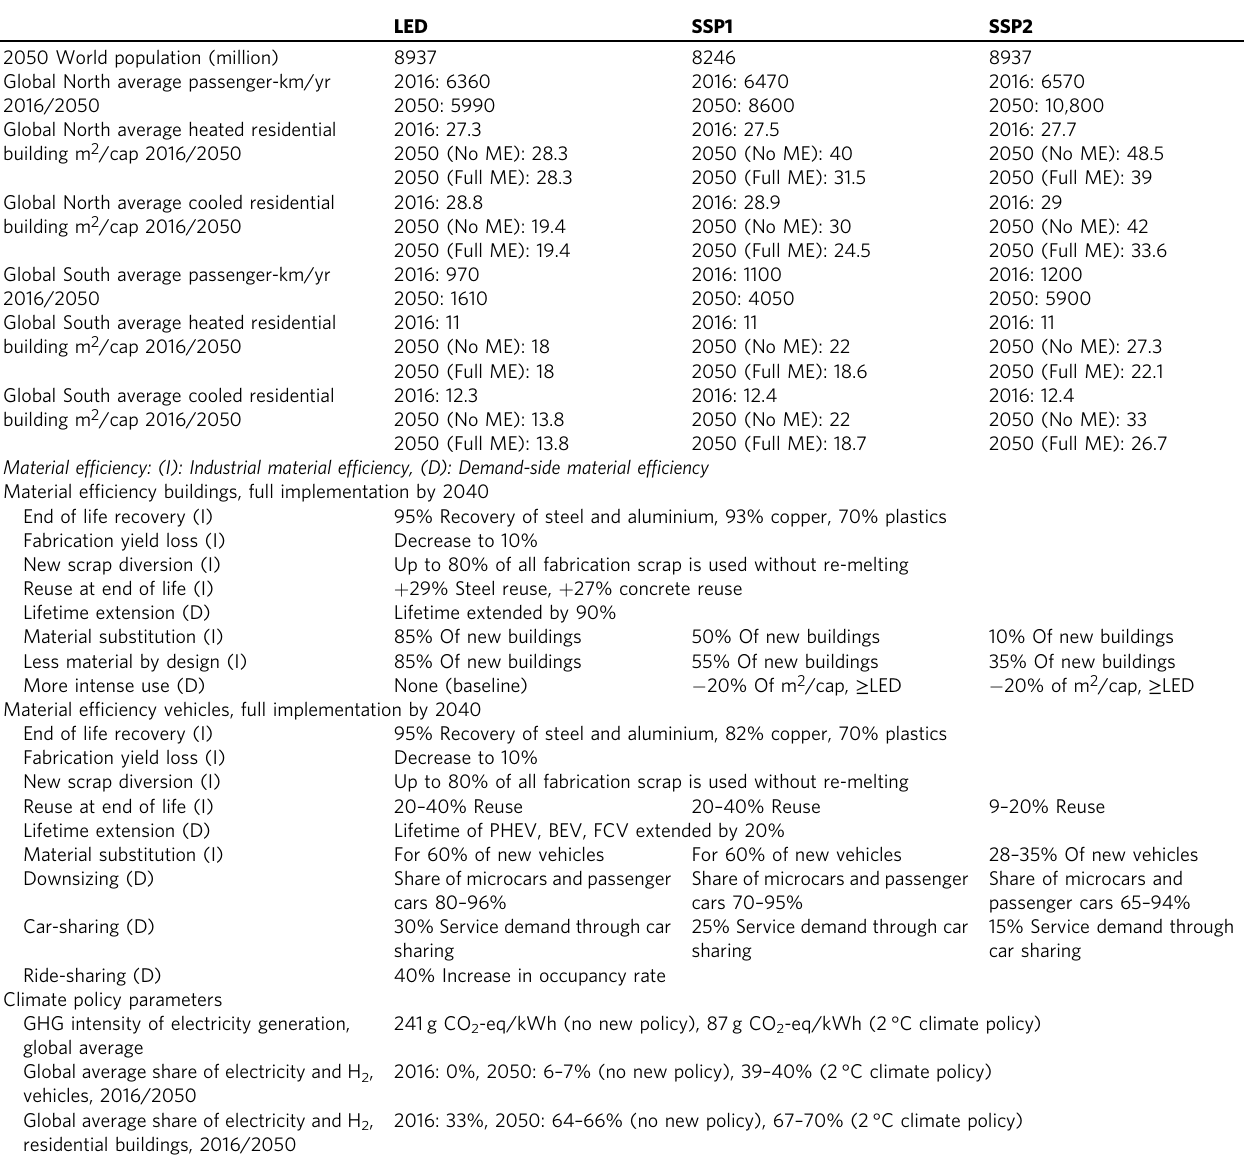
Table 2 RECC Global main input data and